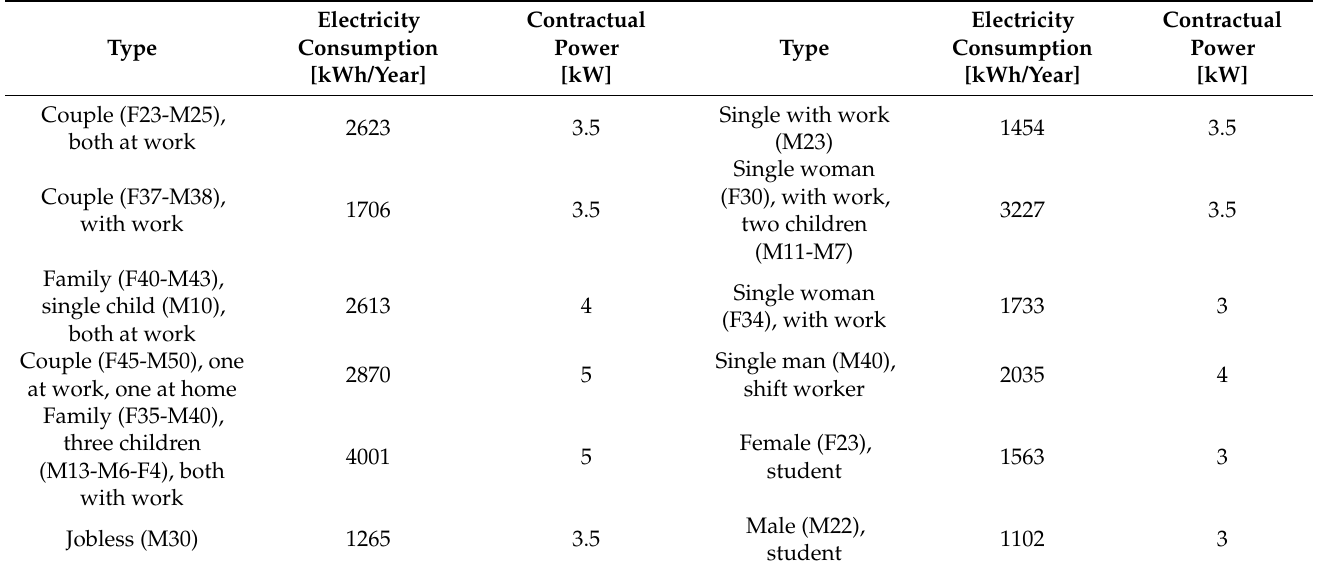
Table 3. Dwellers details, contractual power, and yearly electricity